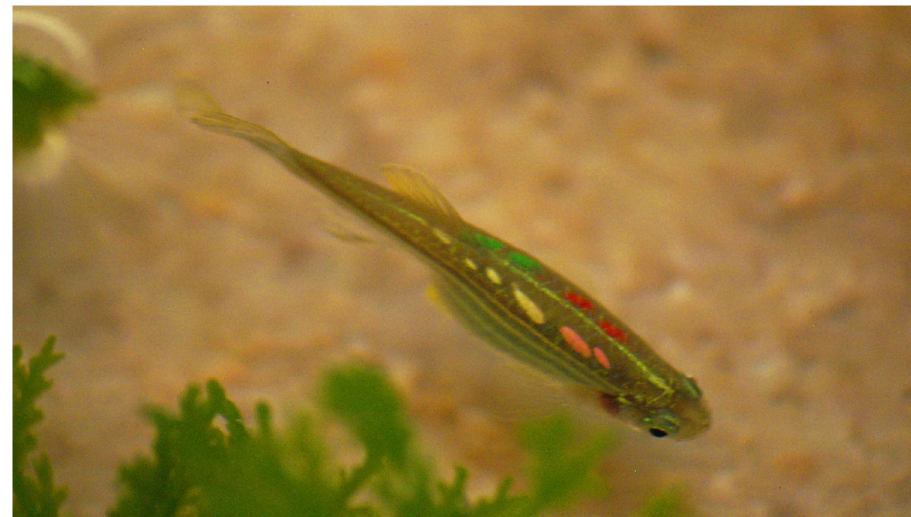
Figure 3. A VIE-tagged individual with fragmented elastomer under the skin. Visible are four coloured marks (as tagged 4 position). Photo credit: Anita Rácz.